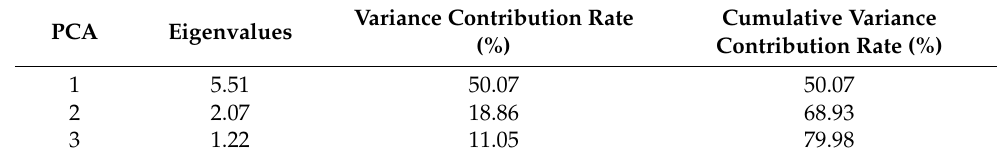
Table 2. Eigenvalue and contribution rate of principal components.